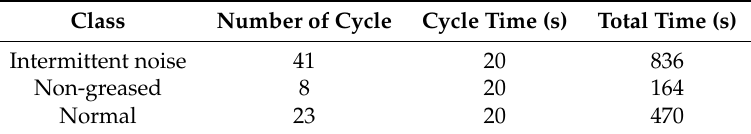
Table 4. Dataset collected from same manufacturing process (Set-B)